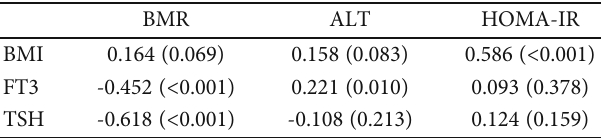
Table 3: Correlations between thyroid index, BMI, and liver function among T2DM subjects with